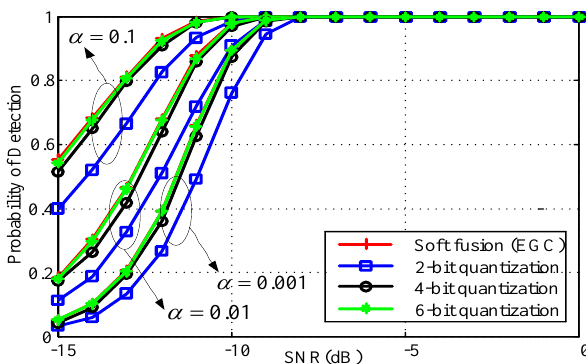
Figure 6. Probability of detection versus signal-to-noise ratio (SNR) for various number of quantization bits and various values for α .